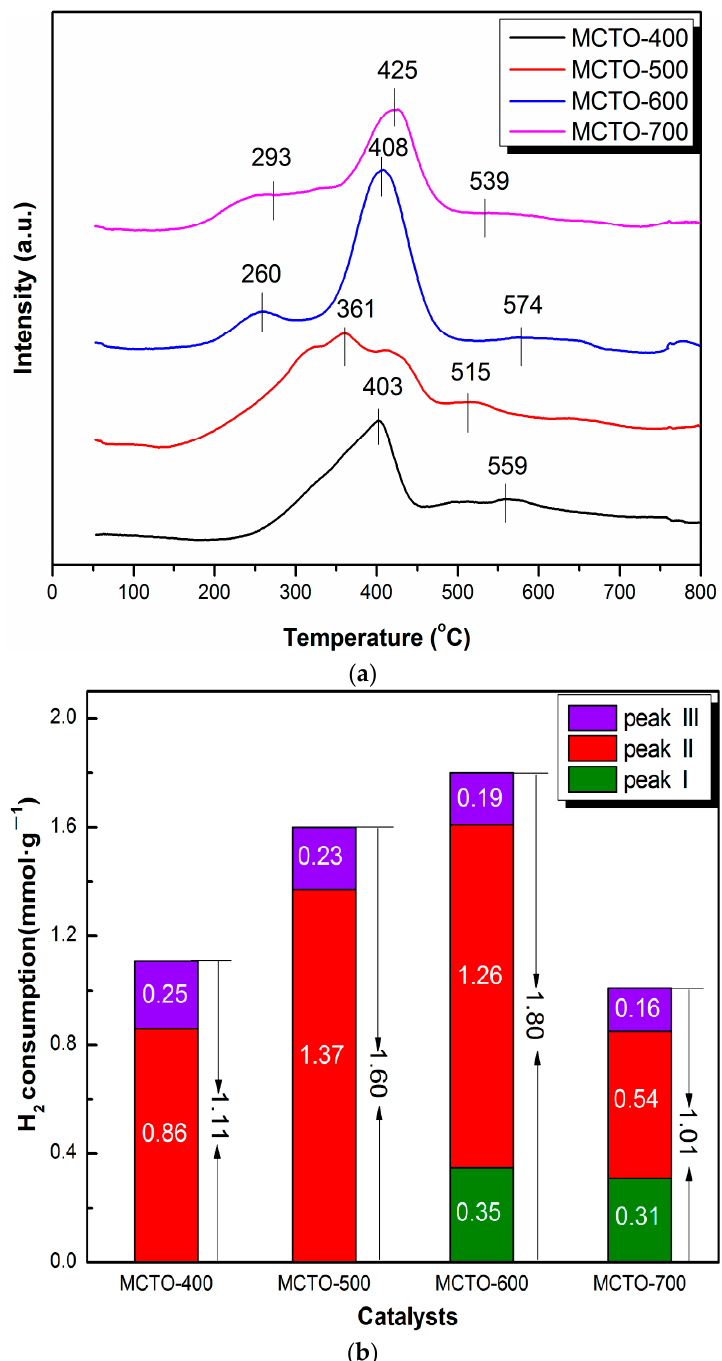
Figure 6. H 2 –temperature programmed reduction (TPR) profiles ( a ) and the corresponding H 2 consumption ( b ) of the MCTO-400, MCTO-500, MCTO-600, and MCTO-700 catalysts.